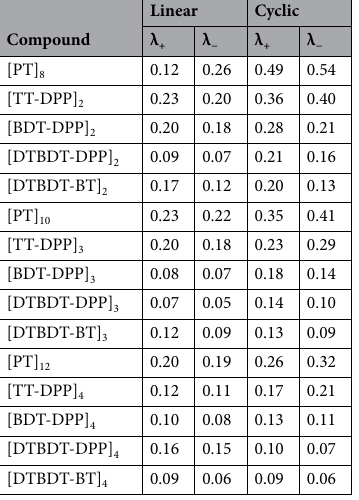
Table 2. Calculated energies (in eV) of hole (λ + ) and electron (λ - ) reorganization of cyclic and linear compounds (eV) calculated at B3LYP-D/6-31G** level of theory.